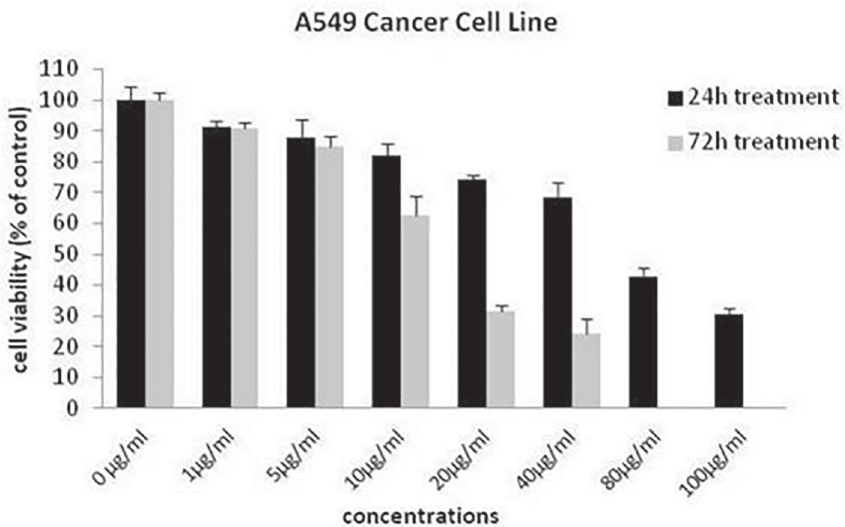
FIGURE 1 - Concentration effectiveness of the Algerian propolis extract on viability of lung carcinoma A549 cells 24 and 72 h after treatment. Values are mean ± standard error of three independent experiments.